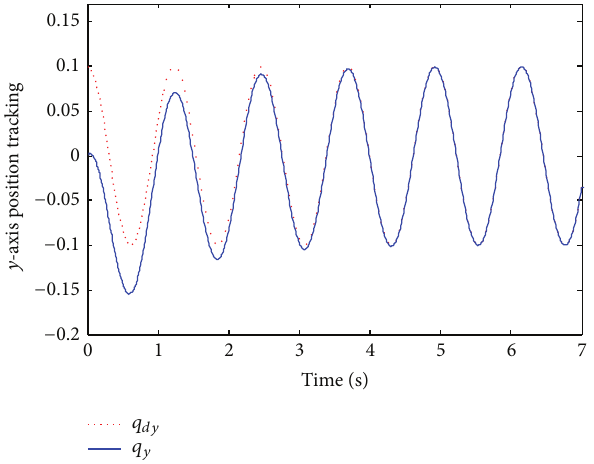
Figure 14: 𝑦 -axis position tracking with neural compensator.